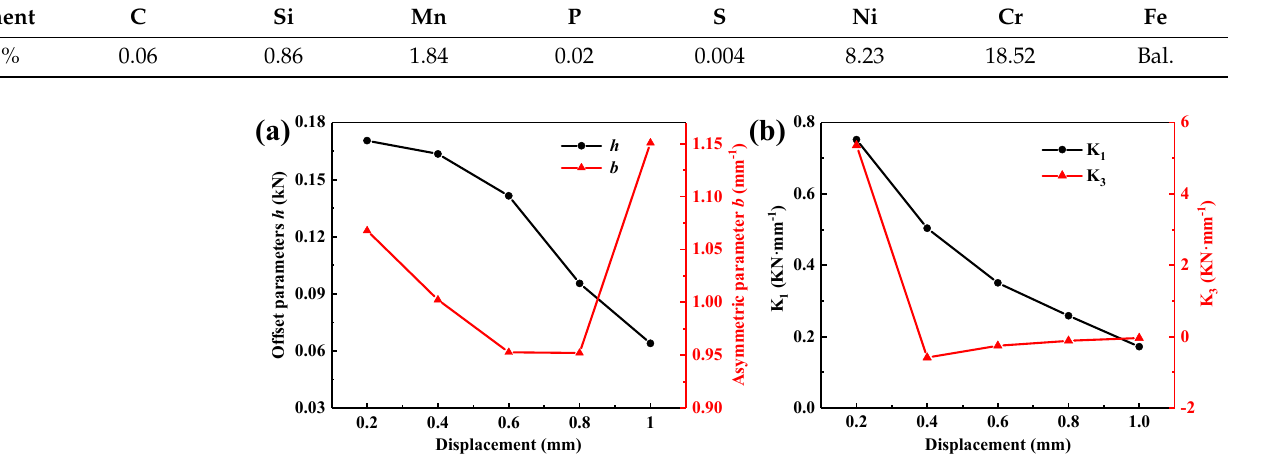
Figure 4. ( a ) Evolution of the parameters h and b with amplitude and ( b ) evolution of the stiffness coefficient with amplitude. Table 3. Fitting results of the parameters h and b .